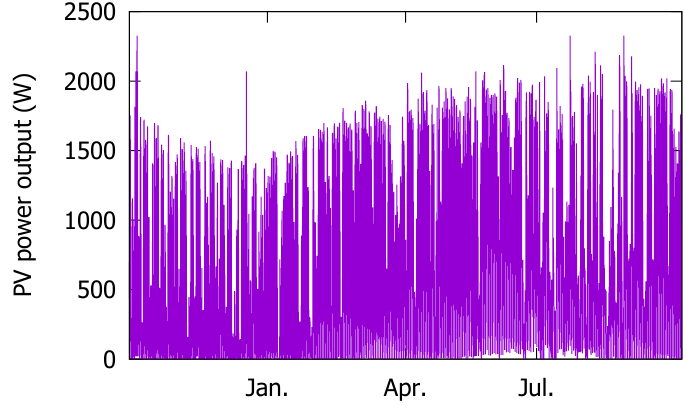
Figure 4. The 2016 photovoltaic (PV) power output